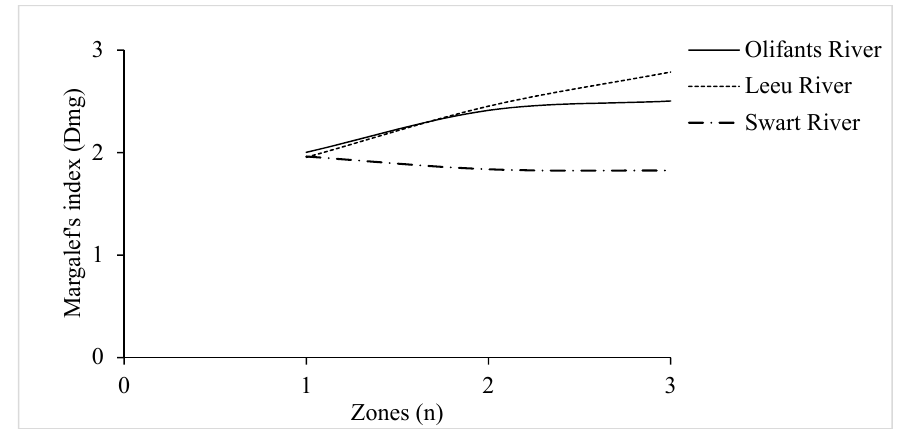
Figure 2. The cumulative species richness curves of Margalef’s index (D mg ) for plants at Olifants (solid line), Leeu (dotted line), and Swart (solid-dotted line) rivers, Western Cape, South Africa. The curves represent successively pooled and randomly ordered samples at three zones sampled. Curves were computed using Estimate S [33]. The formula for the index is D mg = (S-1)/lnN.